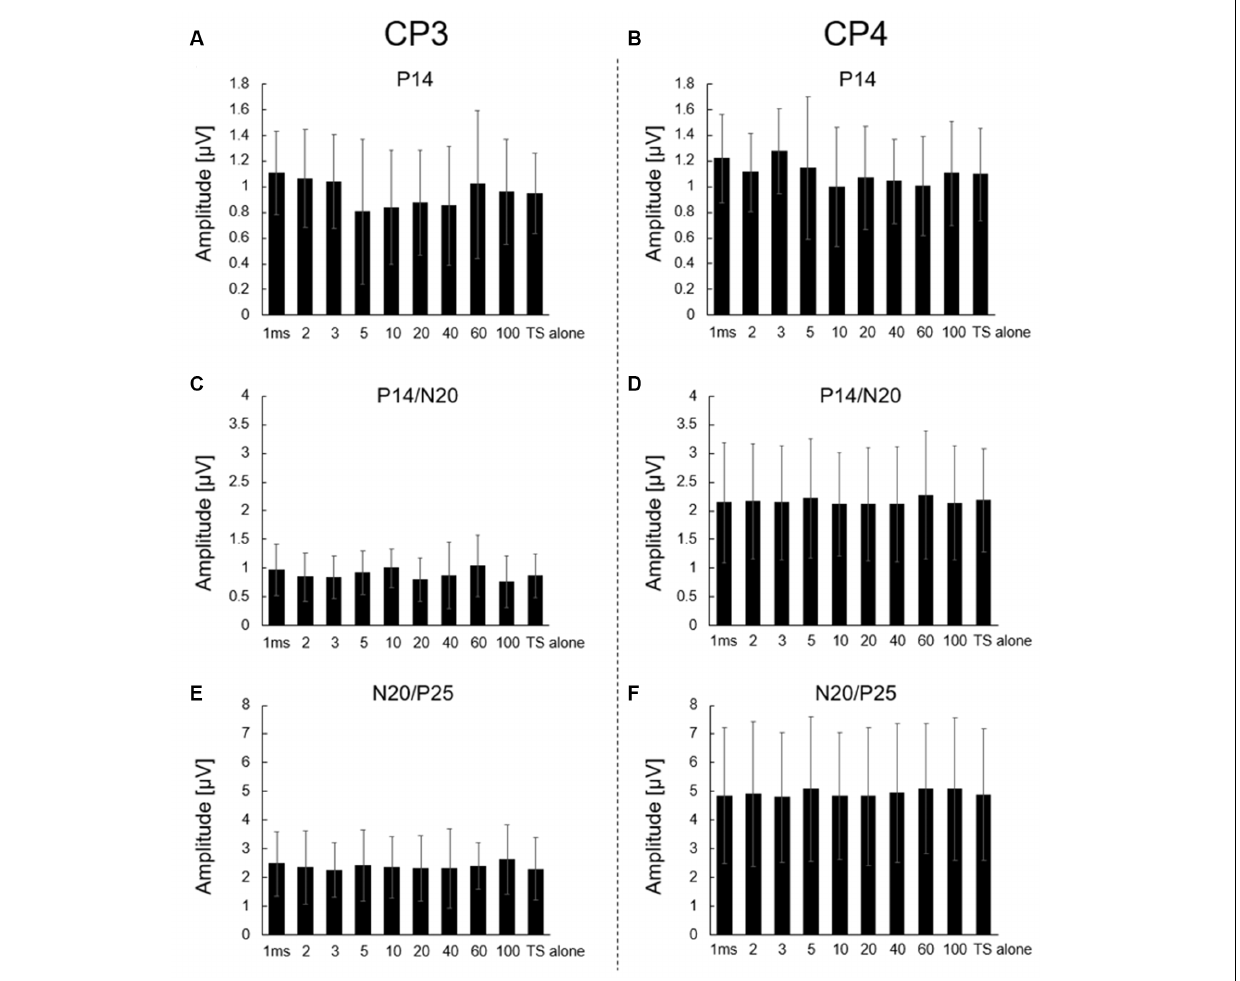
FIGURE 2 | Effect of CS to the right median nerve on P14, P14/N20, and N20/P25 responses of CP3 and CP4 electrodes. Averaged (A,B) P14, (C,D) P14/N20, and (E,F) N20/P25 amplitudes for TS alone and all ISI conditions (1, 2, 3, 5, 10, 20, 40, 60, and 100 ms). Left panels: CP3 electrode; right panels: CP4 electrode. No significant differences were observed between each ISI condition and TS alone condition in all amplitudes. All data are presented as means ±